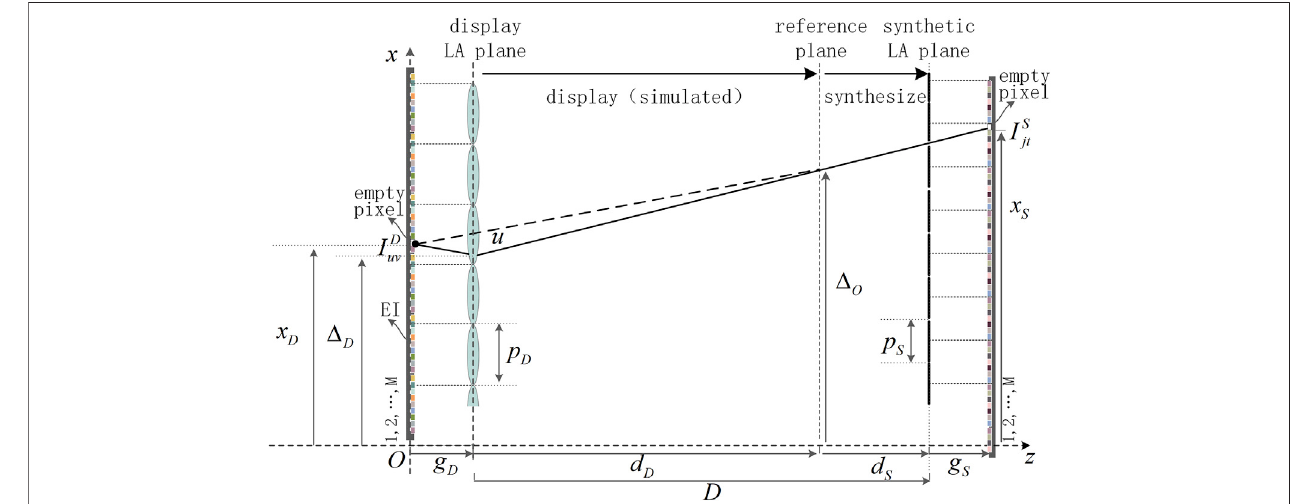
FIGURE 2 | Principle of the SPOC